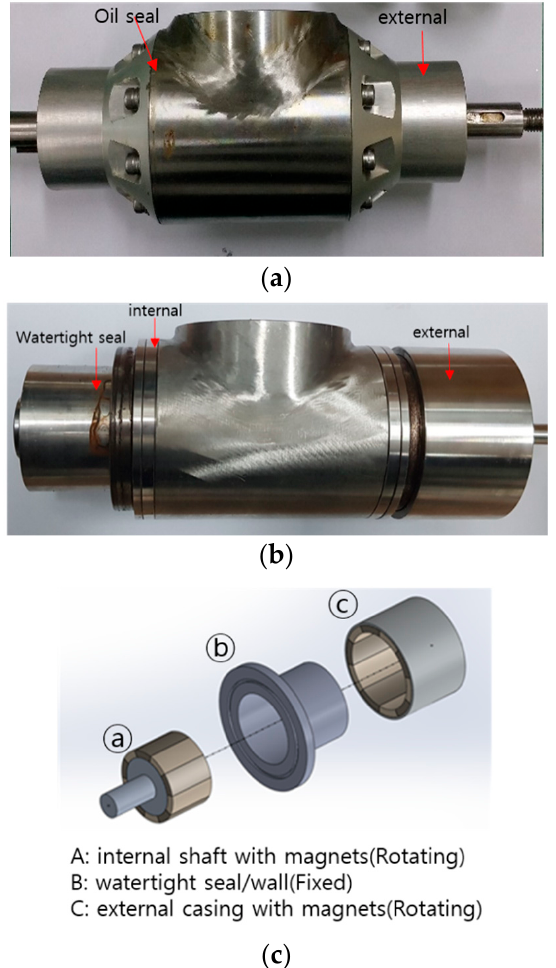
Figure 4. ( a ) Previous Turbine’s mechanical oil seal coupling; ( b ) assembly of magnetic coupling; ( c ) a SolidWorks rendering of magnetic coupling.